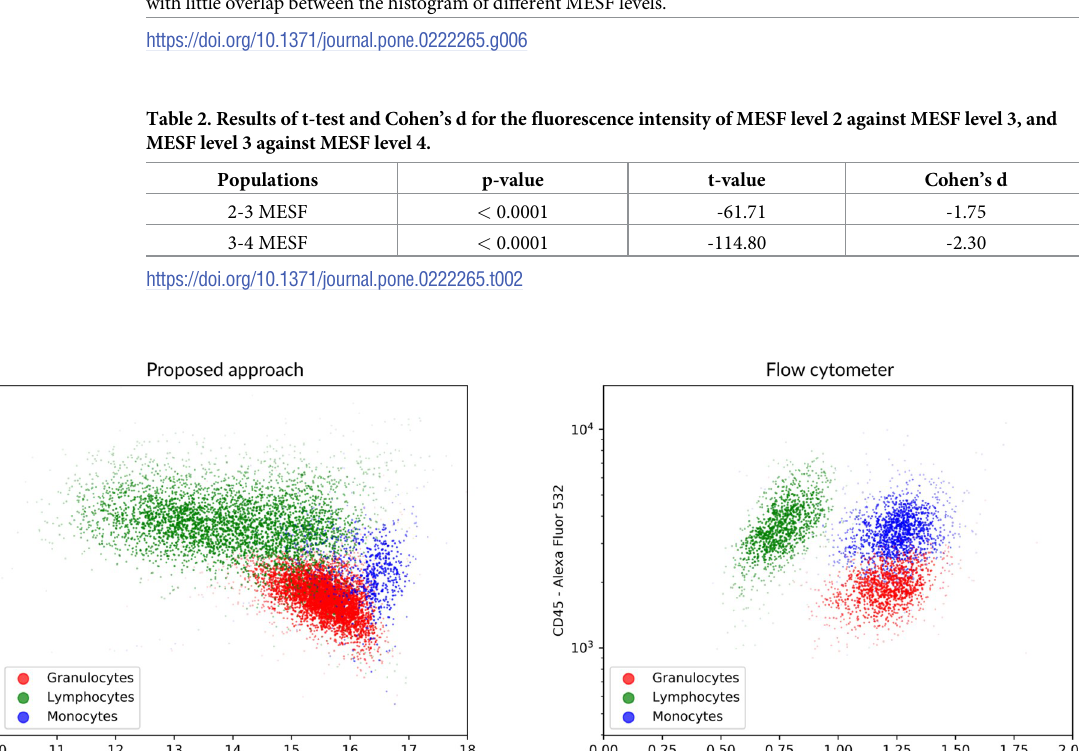
Fig 6. Bead performance. Beads of MESF levels 2, 3, and 4 were analyzed, and the estimated fluorescences were combined into a single histogram. This histogram shows the algorithm is capable of separating the three bead types with little overlap between the histogram of different MESF levels.